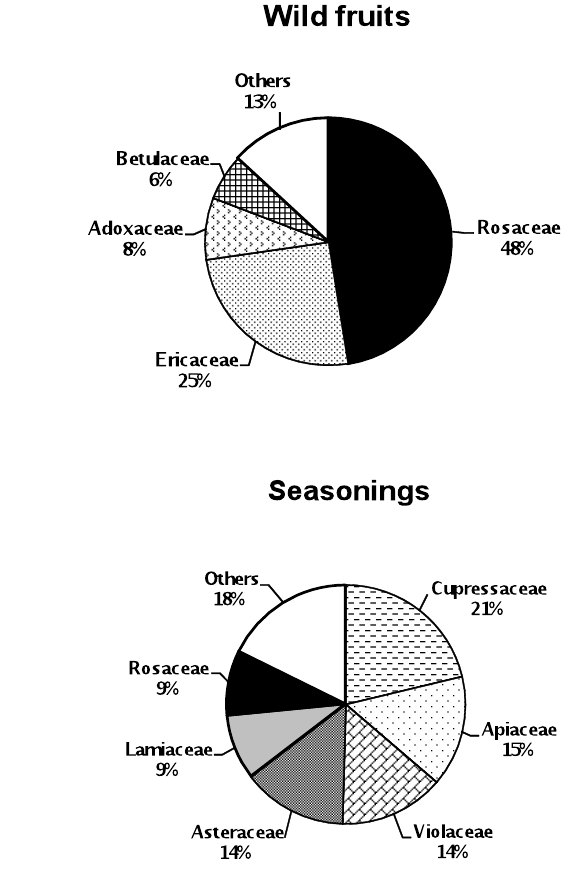
Fig. 1: Botanical families with the greater number of species cited for the major